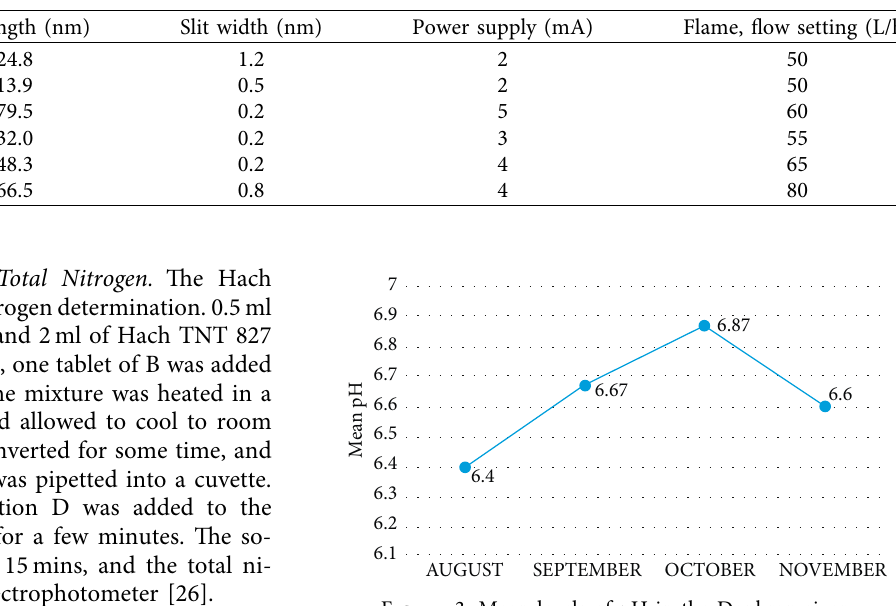
Figure 3: Mean levels of pH in the Dankran river.